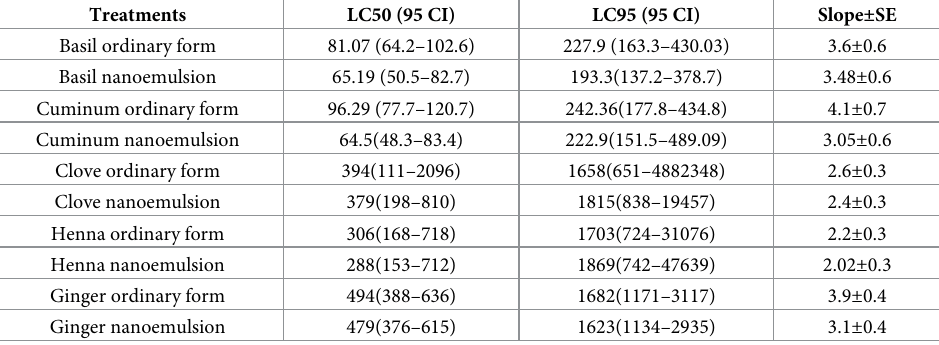
Table 2. LC50 and LC95 of the used essential oils after 24 hours of application. Treatments